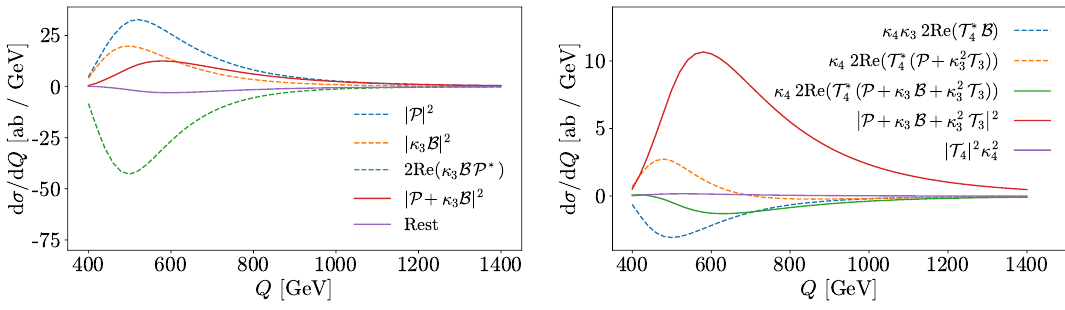
Figure 3 . Di(cid:11)erent contributions to the Spin 0 component of the invariant mass distribution. Left: in dashed lines we show the contributions from the pentagon and box diagrams, as well as their destructive interference, resulting in the red solid line. Right: the contributions separated by their (cid:20) 4 dependence. In dashed lines we show a similar destructive interference pattern, due to the sign di(cid:11)erence between the box and the pentagon (and triangle) form factors, resulting in the green solid